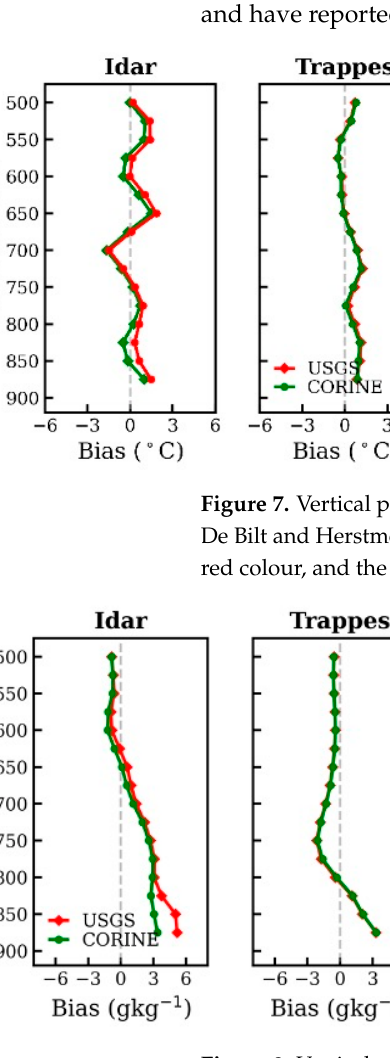
Figure 9. Vertical profile of bias in wind speed over five radiosonde stations (Idar, Trappes, Bergen, De Bilt and Herstmonceux) on 18 August 2011 at 12 UTC. The values by WRF_USGS are presented in red colour, and the values by WRF_CLC are given in green colour.